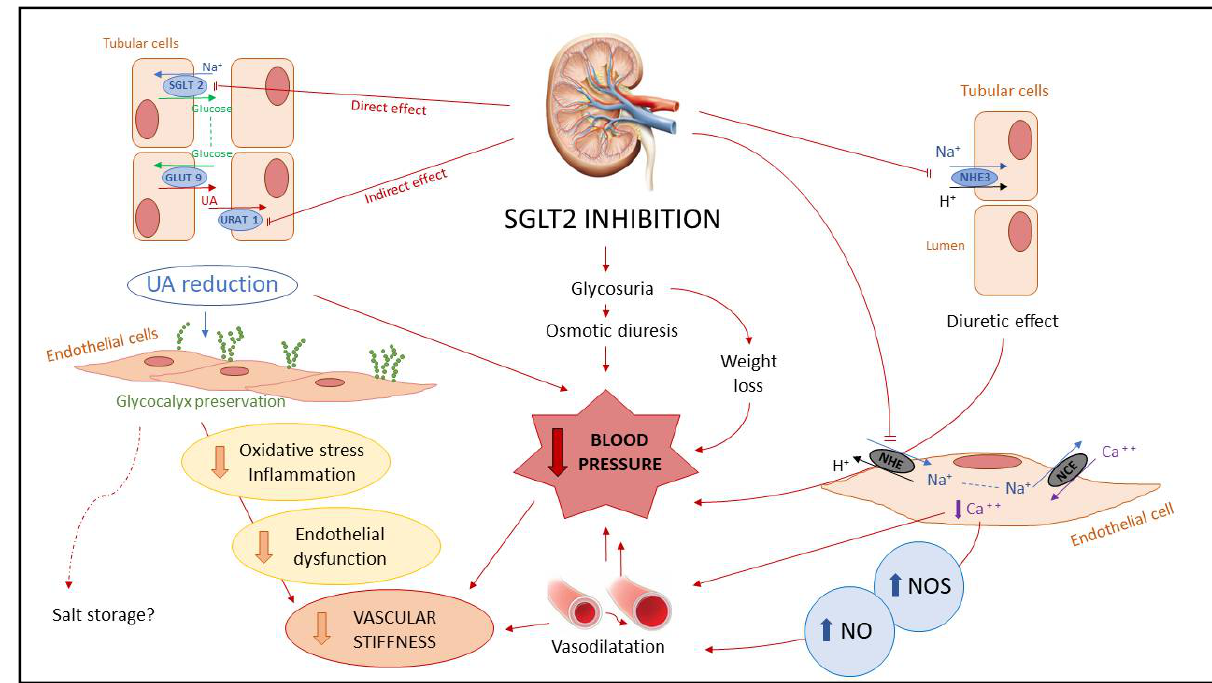
Figure 3. Proposed systemic renal-protective pathways with SGLT2 inhibitors. The potential pathways linking SGLT2is with blood pressure reduction and vascular stiffness improvement involve the intravascular volume depletion via osmotic diuresis due to glycosuria, the lowering of blood glucose (and glucotoxicity), blood serum uric acid levels, and body mass. SGLT2is increase glucose concentrations in the proximal tubules, wherein glucose competes with urates for the transporter GLUT9, reducing urate reabsorption and then increasing renal uric acid excretion as a direct effect. This was speculated to be an indirect effect of SGLT2is on URAT1, as a consequence of the glycemia reduction on insulin amount and other mechanisms not insulin-mediated. It was demonstrated that restoration of the integrity of the endothelial glycocalyx in human cells, possibly resulting in atheroprotective effect and contrasting endothelial dysfunction mediated by oxidative stress and inflammation, leads to a reduction in arterial stiffness. An emerging hypothesis states that sustaining salt storage in the glycocalyx contributes to developing hypertension due to impaired excretory ability of sodium at the kidney level. Furthermore, SGLT2is inhibit NHE in tubular cells, acting as a proximal diuretic; and also inhibit endothelial NHE, leading to decreased intracellular calcium, increasing endothelial NOS and NO levels, allowing vasodilatation. Abbreviations: GLUT, glucose transporter; NHE, Na+/H+ exchanger; NOS, nitrite oxide synthase; NO, nitrite oxide; SGLT2is; sodium-glucose cotransporter 2 inhibitors; URAT, urate